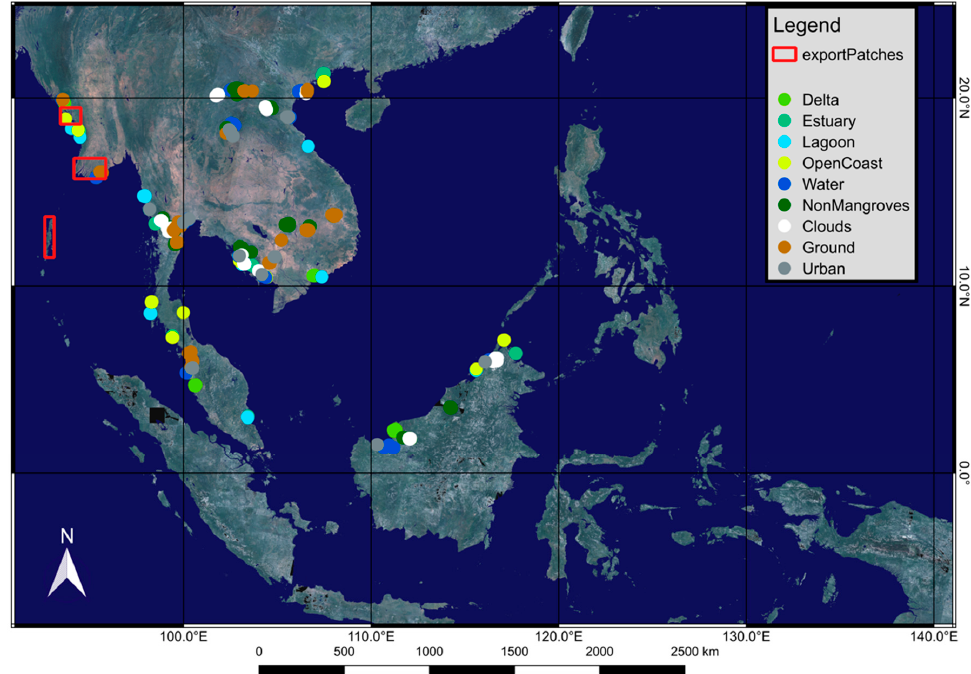
Figure 1. RGB image of Southeast Asia generated in Google Earth Engine using the cloud-masked Sentinel-2 sensor mosaicked imagery captured in 2016. The image does not show all the classification points due to its scale, and each point on the map represents a cluster of multiple points. Points and export areas were also generated on GEE. Table 2. Number of mangroves’ shapefiles used in each country within the area of interest (AOI) (left panel) and points used for each of the classes identified in each country (right panel). Philippines and Indonesia were not used due to the complexity and small size of their respective countries’ boundaries, making image processing and class identification challenging. The number of points for each class was kept constant at twenty, where possible (some countries did not have some of the mangroves’ typologies, or the shapefiles were too small), to overcome the imbalance in mangroves’ shapefiles count in each country.